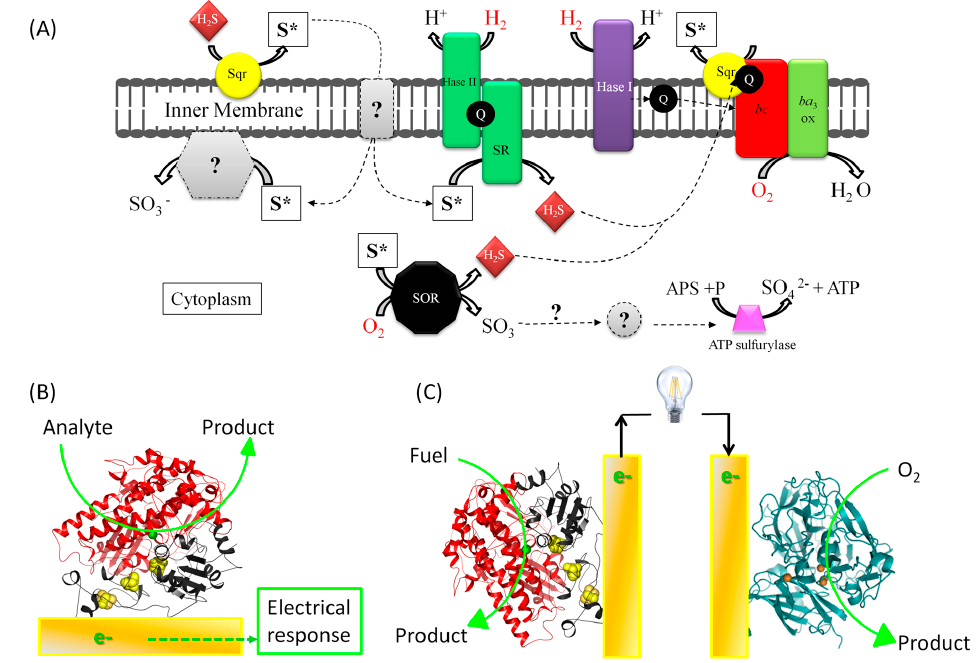
Figure 1. Electron transfer (ET) involving immobilized enzymes on interfaces: from metabolic ET chains ( A ) to biosensors ( B ) and enzymatic fuel cells ( C ). ( A ) is a schematic view of A. aeolicus metabolisms adapted from